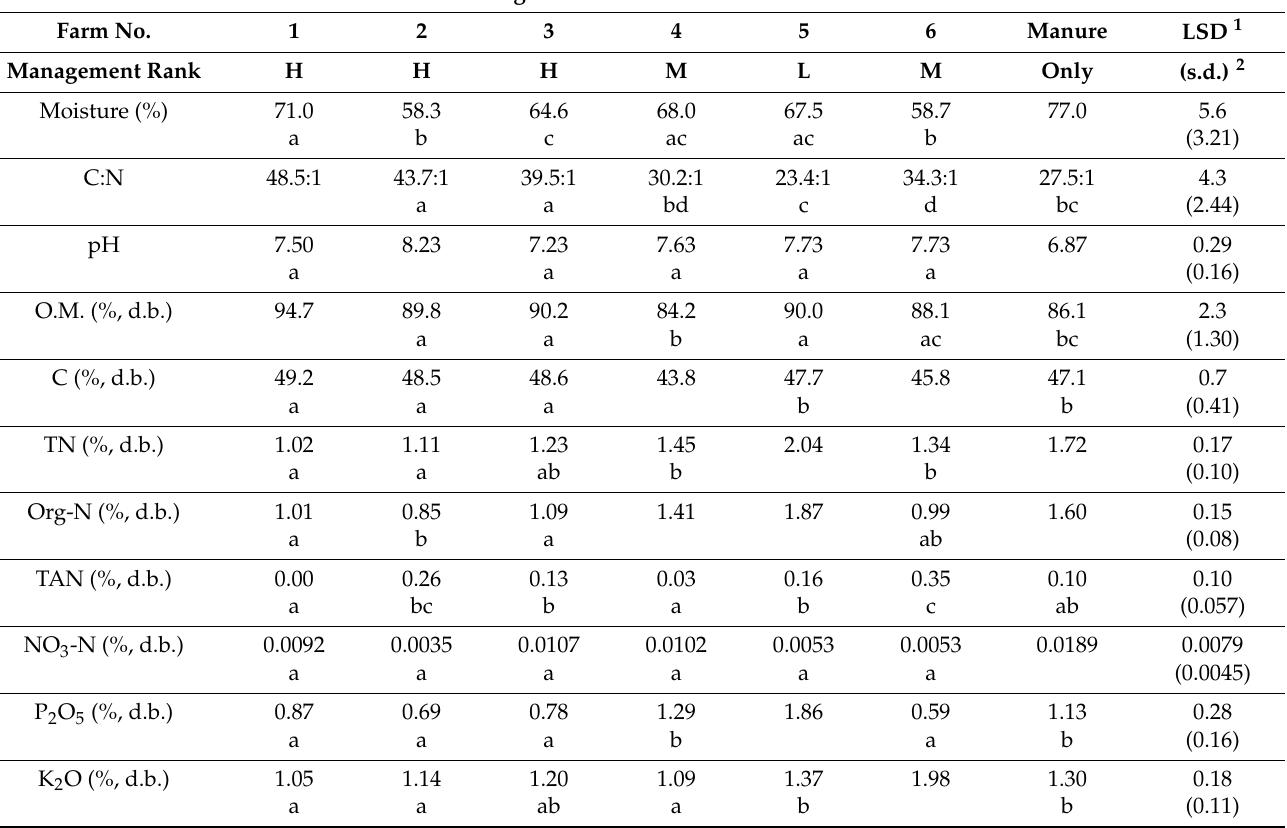
Table 2. Major plant nutrients, organic matter, carbon, moisture contents, and pH of horse manure. Treatment means with the same letter below were not significantly different. Comparisons were made across the